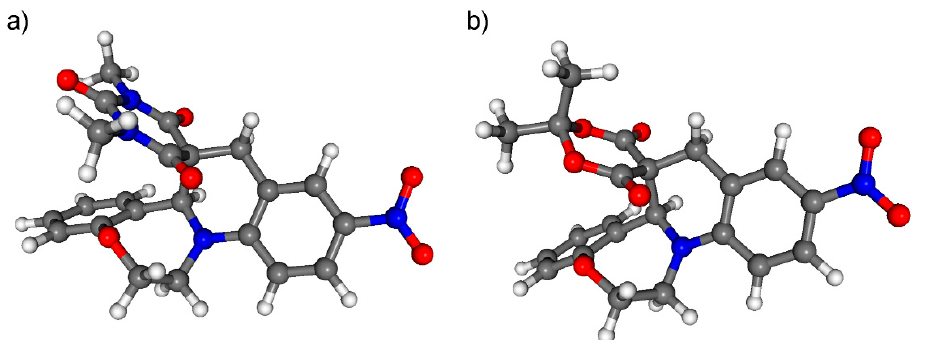
Figure 1. ( a ) Lowest-energy conformers of ( S )- 10a (99.1% population) and ( b ) ( S )- 11a (>99.9% population). Level of DFT optimization: CAM-B3LYP / TZVP PCM / n -octanol.